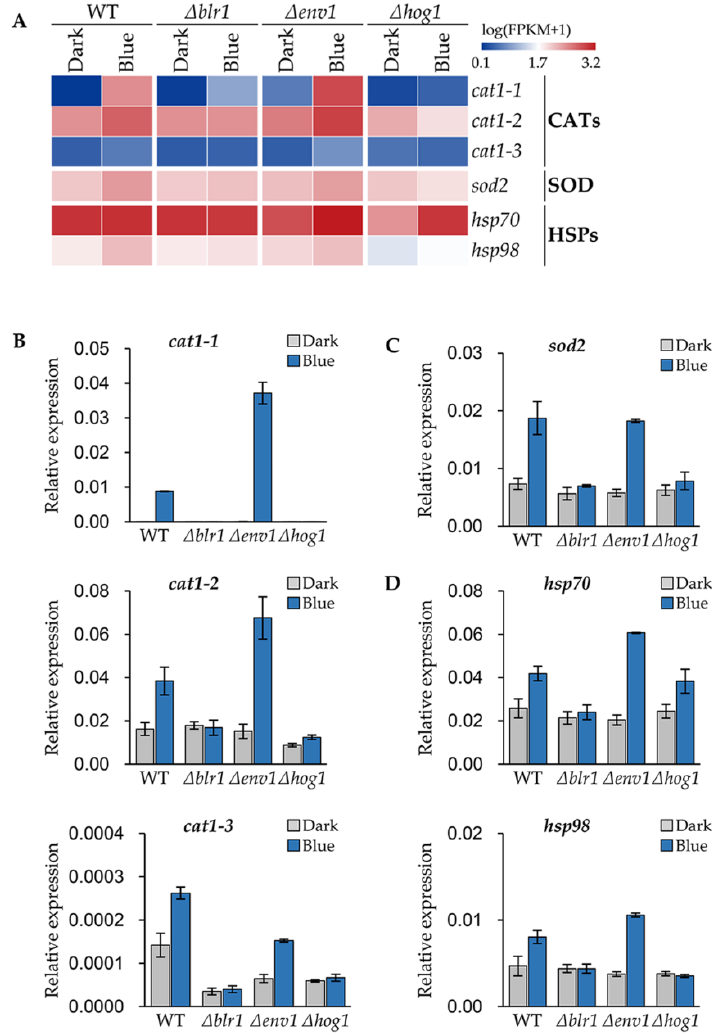
Figure 6. Blue-light-regulated stress response genes identified in T. guizhouense . ( A ) Transcriptional abundance of the catalase (CAT)-, SOD- and HSP-encoding genes. ( B – D ) Expression levels of the catalase- ( B ), SOD- ( C ) and HSP- ( D ) encoding genes in wild type, and the Δ blr1 -, the Δ env1 - and the Δ hog1 -mutant strains. All strains were cultured on PDA medium at 28 °C for 24 h and then kept in the dark or exposed to blue light for 45 min. The expression level of the gene was normalized to the tef1 gene. Error bars indicate SD of three biological replicates.